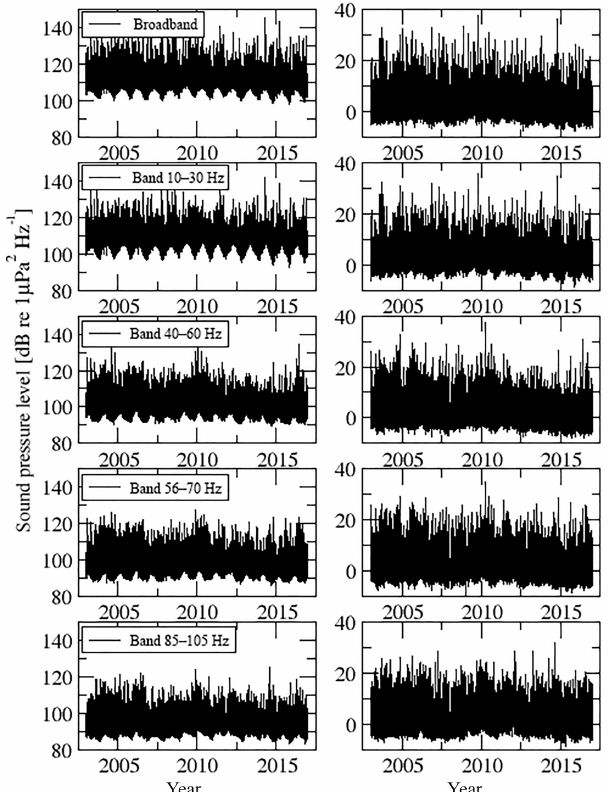
Figure 1. Initial (a) and processed (b) sound pressure level data in five frequency bands. Processing included interpolation and desea- sonalization. Note that seasonal variability is less pronounced in the higher frequencies of the initial data. At the same time, the records of higher frequencies have declining trend visible by